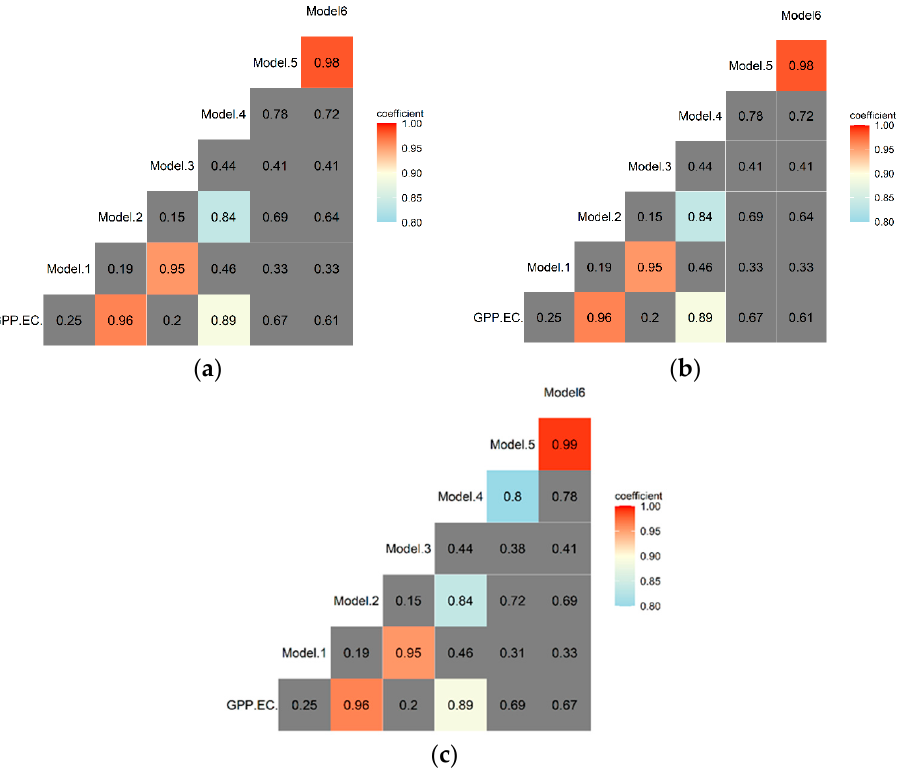
Figure 6. The correlation matrix of modelled and EC-derived GPP for 2019 and 2020: ( a ) Correlation matrix for ε = 0.61, ( b ) Correlation matrix for ε = 0.83, ( c ) Correlation matrix for ε = 1.2 (warmer colors represent stronger positive correlation, cold colors represent moderate positive correlation, and grey color represents correlation values lower than 80%).